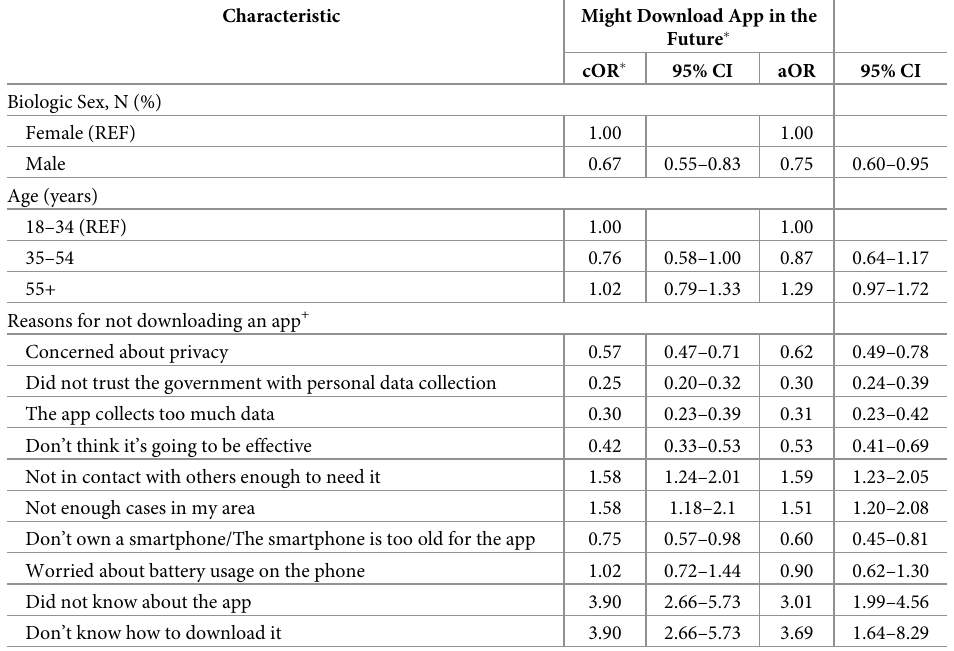
Table 4. Associations between demographic characteristics, reasons for not downloading an app, and potential for downloading a contact tracing app in the future.